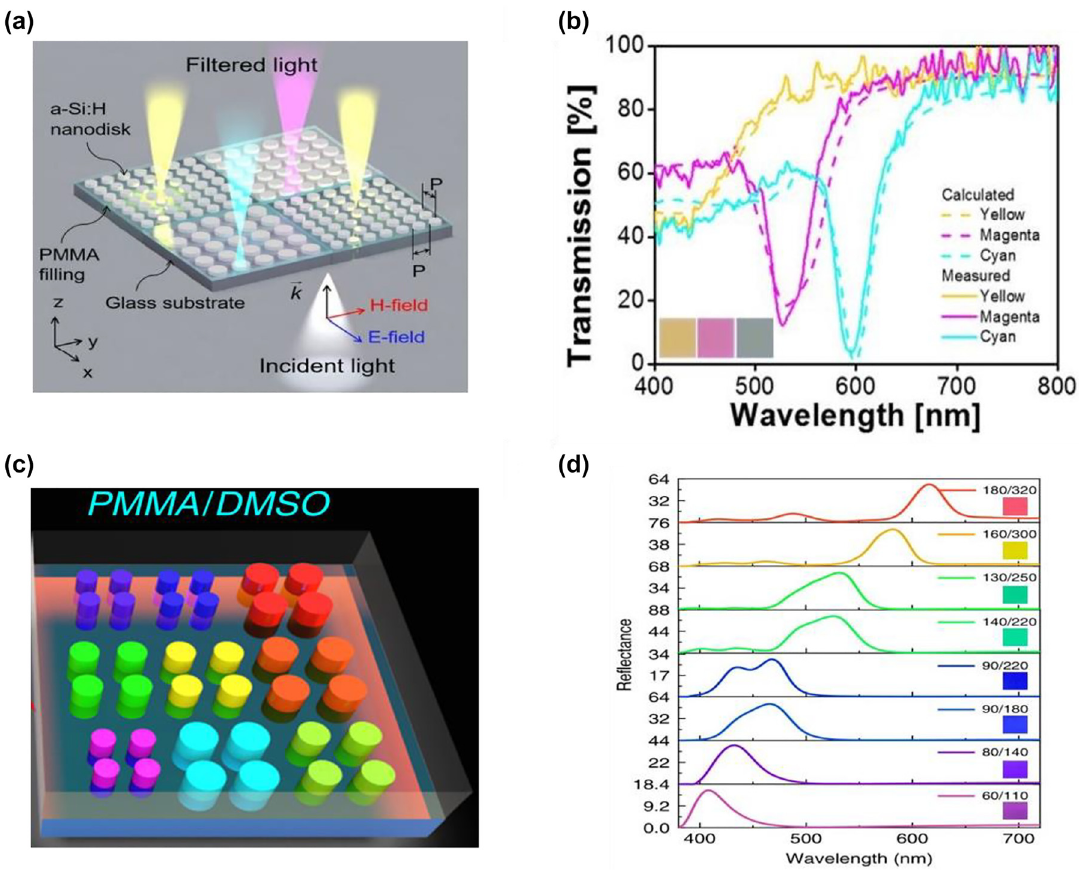
Figure 13: Si based Mie resonance for structural color generation. (a) Schematic illustration of Mie resonators for transmission-type structural color generation, where each unit consists of a 2D α -Si:H nanodisk arrayed on a glass substrate. The nanodisks are embeded inside PMMA. (b) Calculated (dashed curves) and measured (solid curves) transmission spectra of yellow, magenta, and cyan colors. Insets: photos of the generated colors. The height of the nanodisk is fixed as 80 nm, and its period (diameter) is chosen as 150 nm (80 nm), 330 nm (130 nm) and 379 nm (170 nm) to generate the yellow, magenta, and cyan color, respectively. Reproduced with permission [165]. Copyright 2017, Nature Publishing Group. (c) Schematic illustration of Mie resonators for reflection-type structural color generation. The device is composed of arrays of Si nanodisks on a sapphire substrate, over-coated with a refractive index matching layer (PMMA or DMSO). (d) Experimentally measured reflection spectra of the 100-nm thick Si metasurfaces with different lattice sizes (Diameter (R), Period ( l )). Insets: recorded colors under bright-field microscope. Modified with permission [166]. Copyright 2020, Nature Publishing